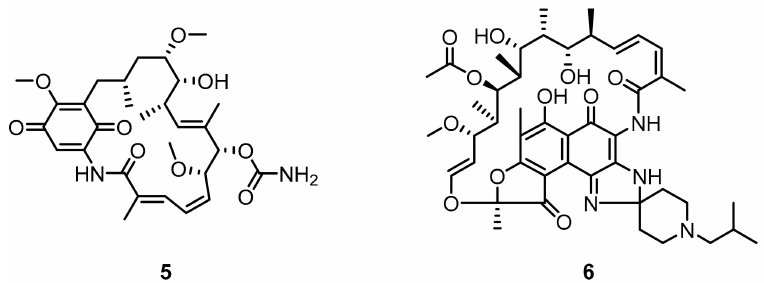
Figure 4. Geldanamycin ( 5 ) and Rifabutin ( 6 ) as the PD-L1